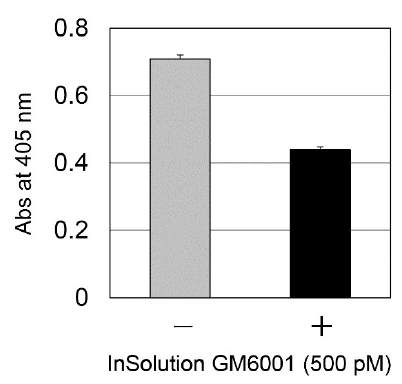
Figure A7. In vitro activation of endogenous TGF- β 1 in HPDL cells cultured with or without MMP2 inhibitor after Er:YAG-LI. HPDL cells were incubated without ( − ) or with (+) 500 pM of InSolution GM6001 (MMP2 inhibitor)(Calbiochem/Merck Millipore, Darmstadt, Germany) for 5 days after Er:YAG-LI. Endogenous TGF- β activity in HPDL cells was evaluated by determining ALP-inducing activity in HPDL cells ( n = Table A1. Selected primers, size of amplified product for qPCR analysis shown in main Figure 3.